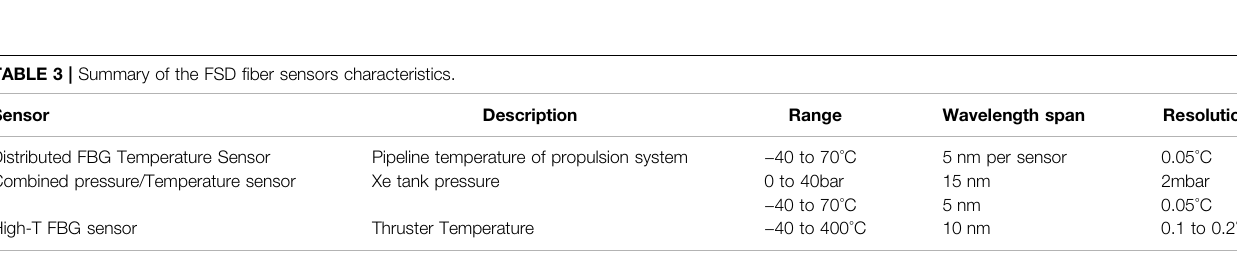
TABLE 3 | Summary of the FSD fi ber sensors characteristics.